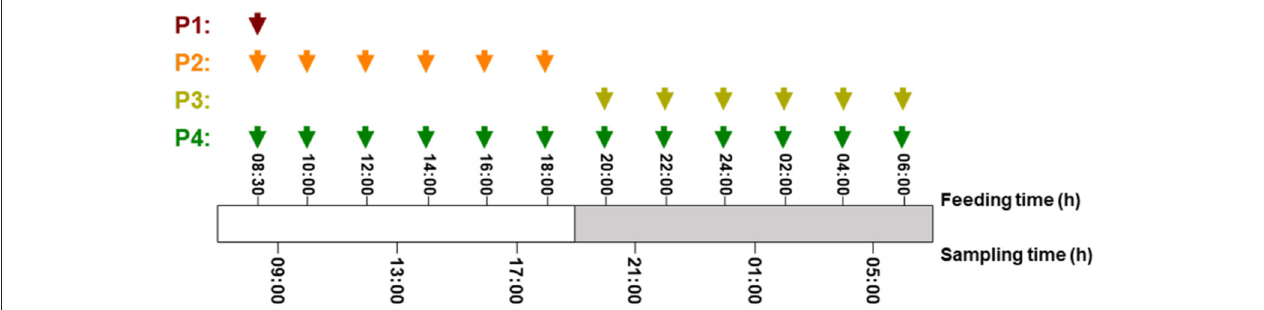
FIGURE 1 | Detailed schema for feeding and sampling schedule in S. senegalensis fed different daily protocols. Red, orange, yellow, and green arrows indicate feeding hours in protocols 1, 2, 3, and 4, respectively.